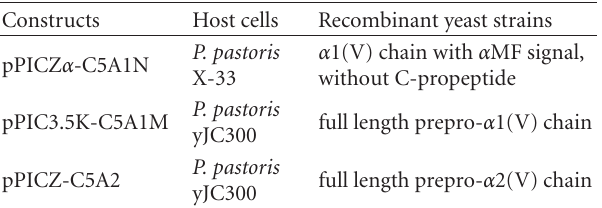
Table 1: Yeast expression constructs, host cells, and recombinant